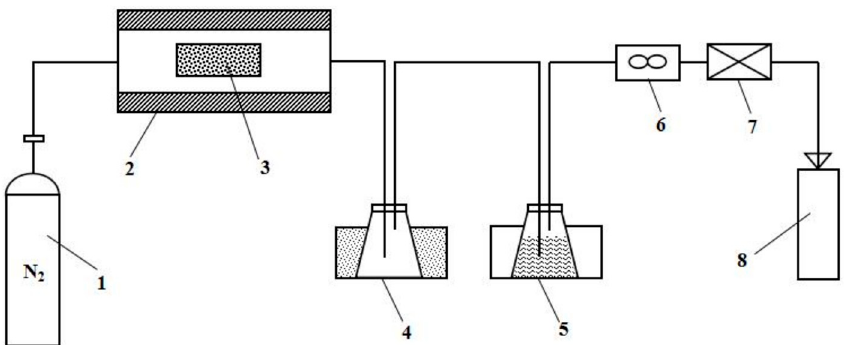
Figure 1. Schematic diagram of the experimental apparatus of the pyrolysis system. 1: nitrogen bottle; 2: tube furnace; 3: quartz tube; 4: condensing unit; 5: hydrogen–chloride absorption bottle; 6: gas flowmeter; 7: dryer; 8: gas bag.